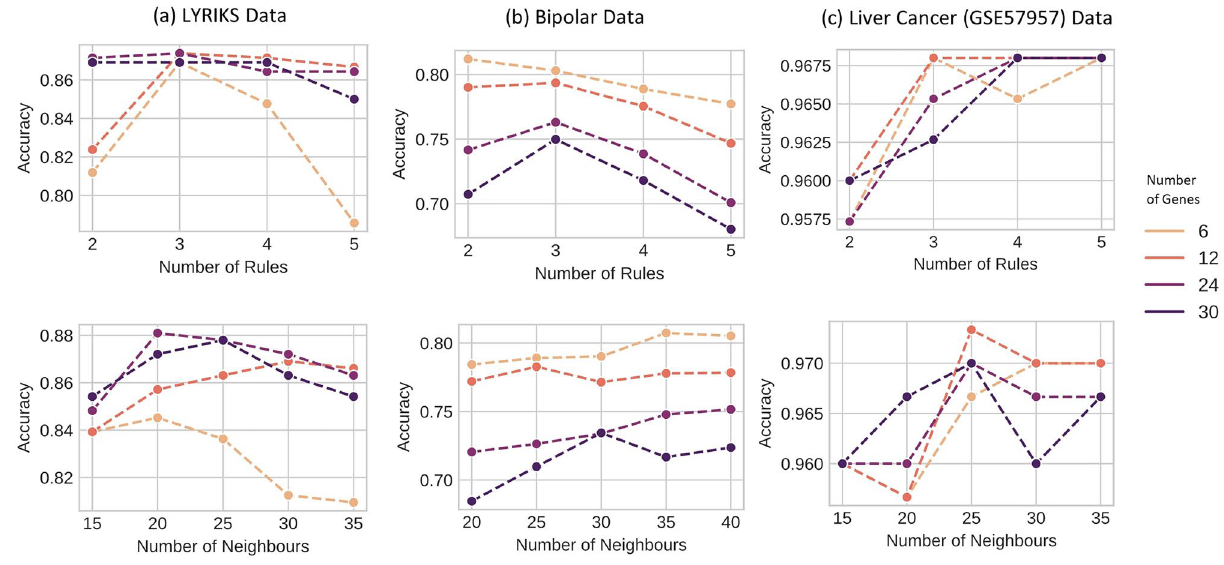
Figure 2. Accuracy given number of rules and neighbours. ( a ) Changes in accuracy for classification of UHR, ( b ) Bipolar subjects and ( c ) HC tissue given different number of rules, neighbours (from each class) and